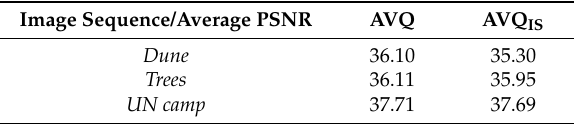
Table 8. Average PSNR (dictionary composed by 8192 entries)–Dataset